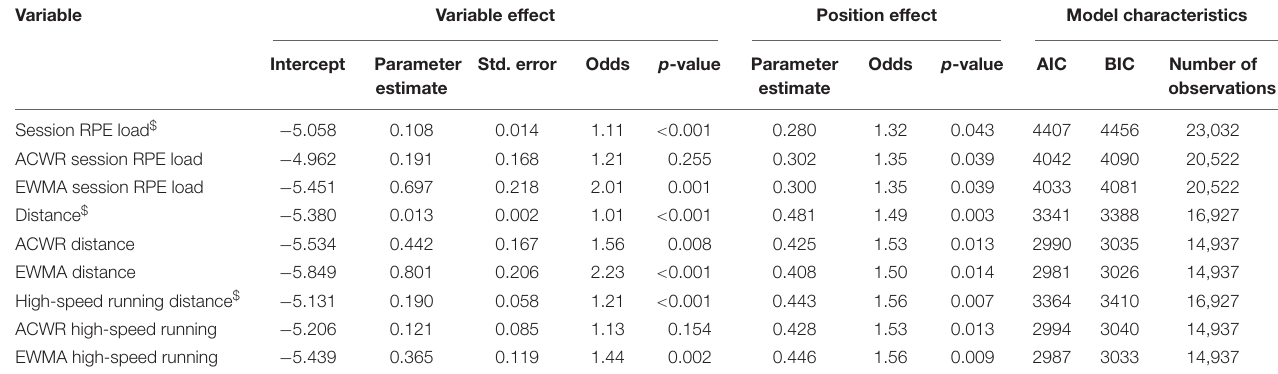
TABLE 2 | Multilevel model